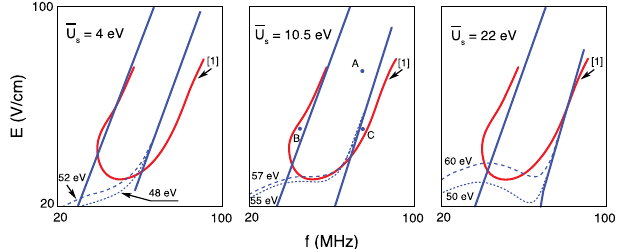
FIG. 1. Experimental curve [1] and calculated borders of the multipactor zone for different values of the initial energy secondary electrons. Electrode separation is 3 cm. The straight solid lines are obtained from the condition of stability, dashed and dotted lines correspond to a border with SEY ¼ 1 with different impact